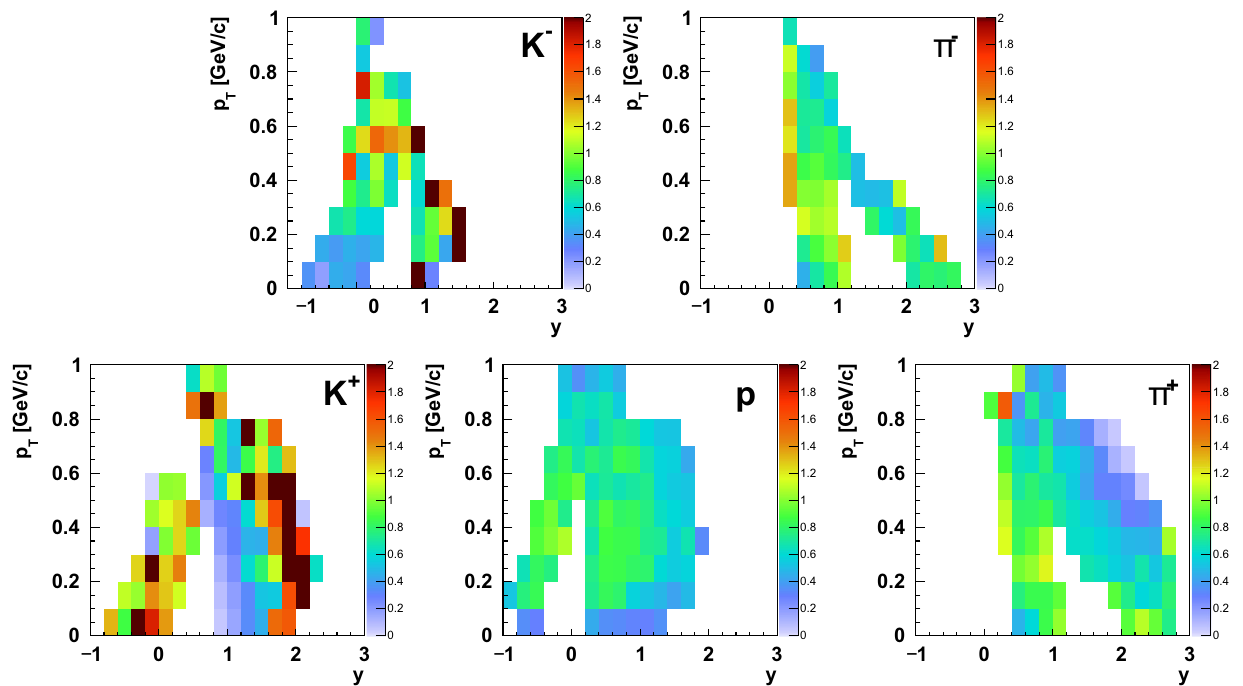
Fig. 41 Two dimensional distributions d 2 n /( dp T dy ) of π − , π + , K − , K + and p produced in inelastic p + p interactions at 20 GeV / c divided by the U r QMD 3.4 model [27,28] calculations